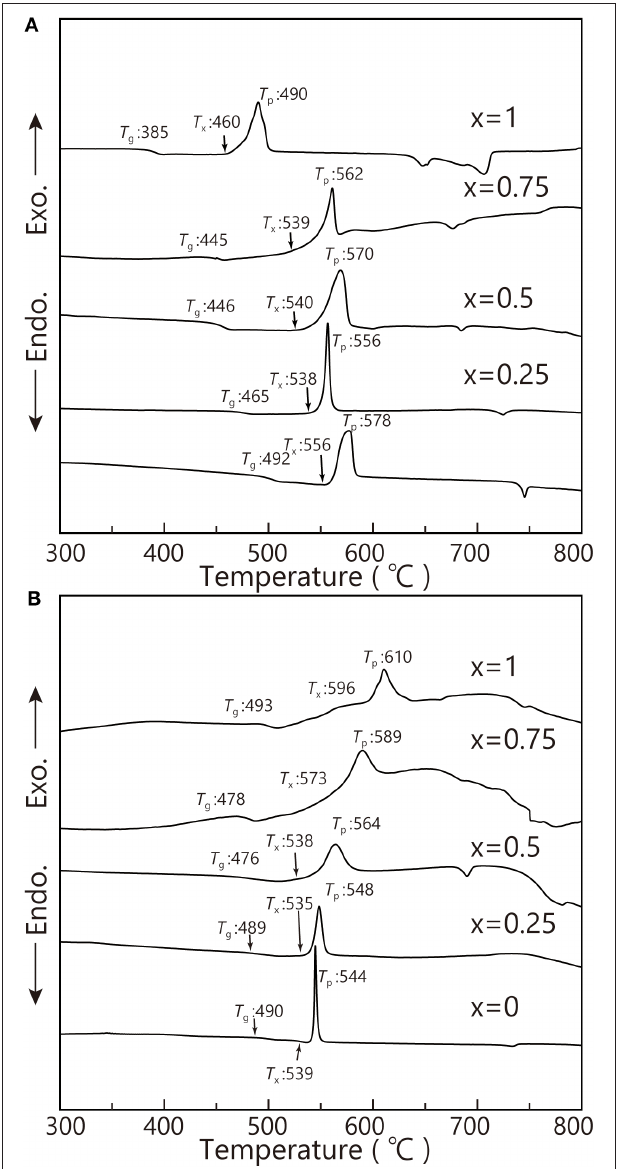
FIGURE 4 | DTA curves of Na 2 Fe x Ni 1 − x P 2 O 7 glass, (A) bulk; (B) powder.